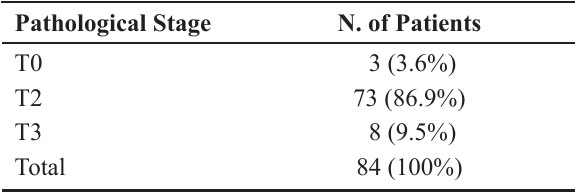
Table 4 – Pathological stage (TNM) of